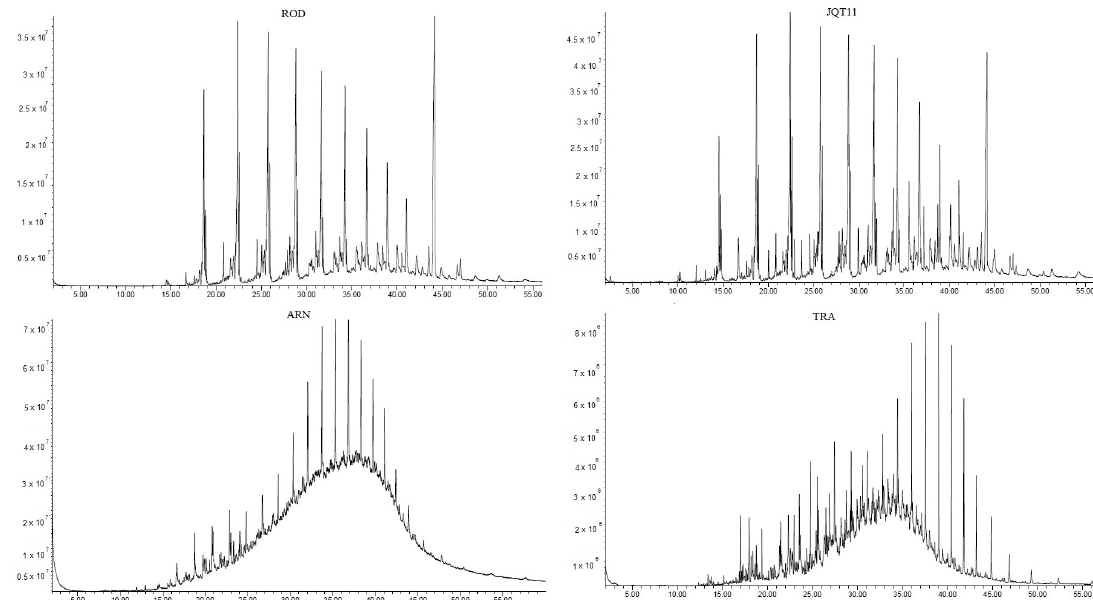
Figure 3 Figure 3. Chromatograms of four di ff erent sites (ROD, JQT, ARN and TRA) analyzed by gas chromatography coupled to flame ionization detection